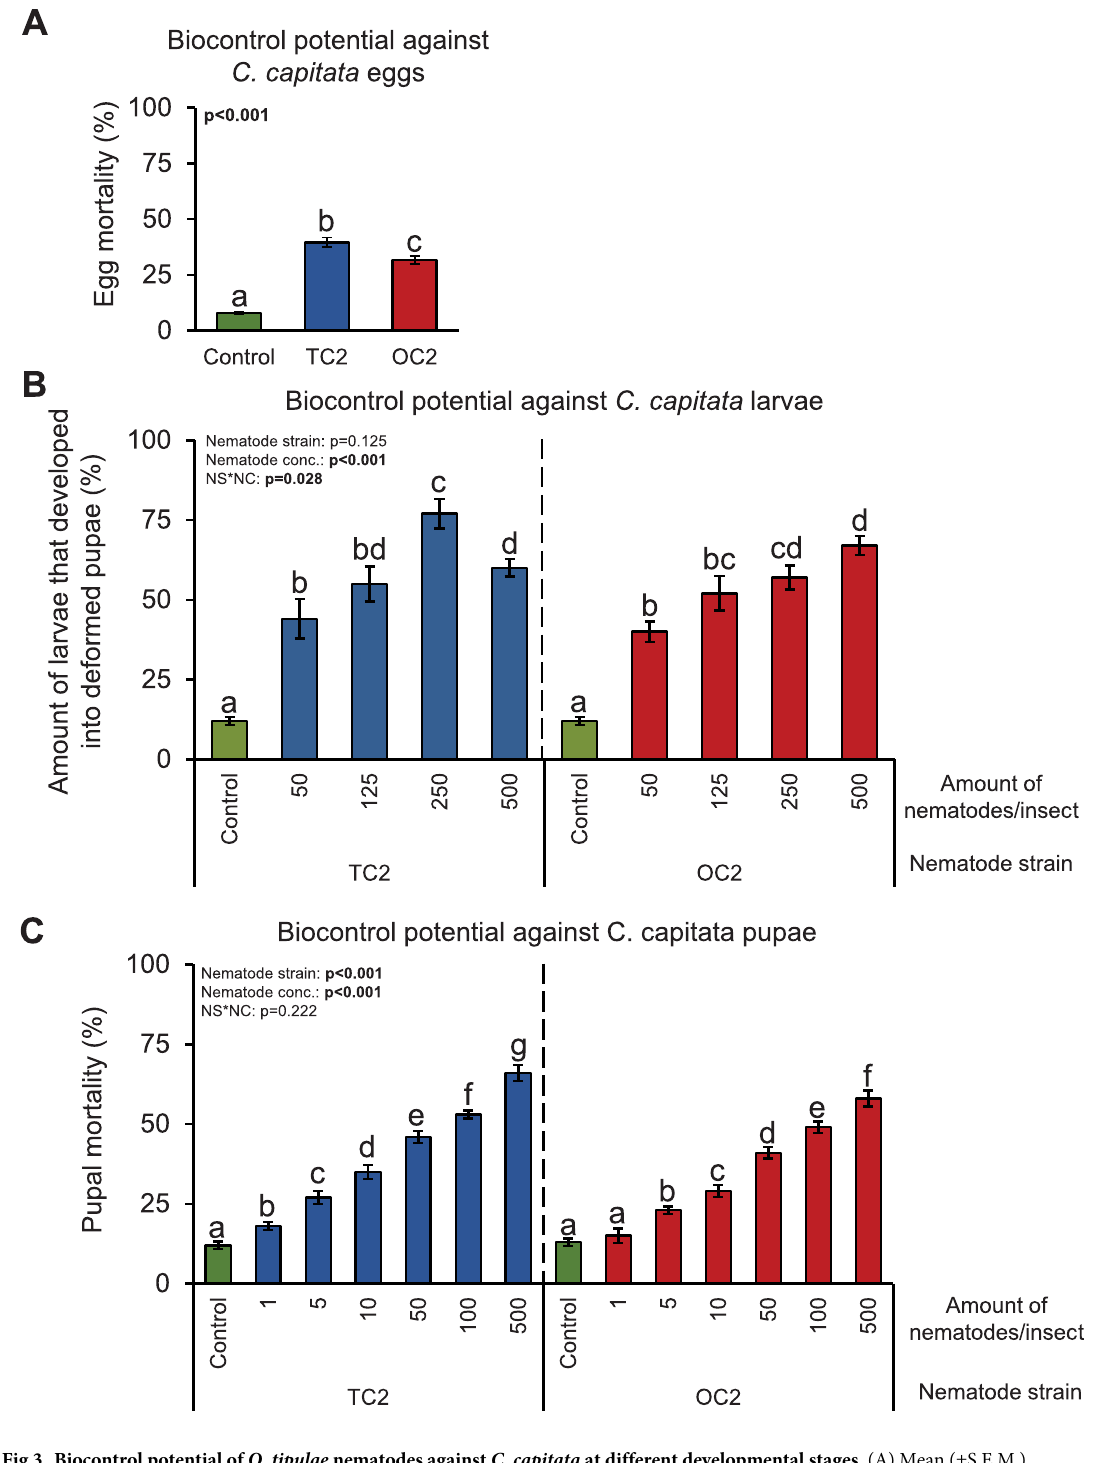
PLOS ONE | https://doi.org/10.1371/journal.pone.0269106 June 7, 2022 9 /